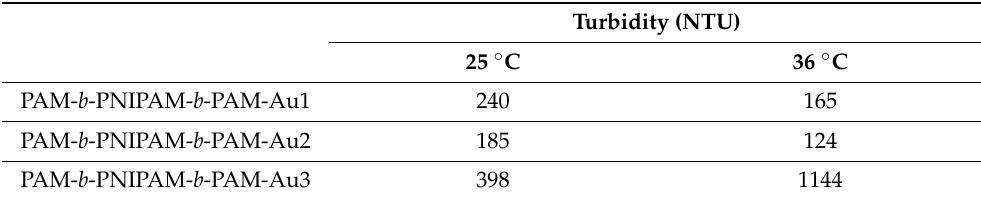
Figure 5. DLS number–size distribution of the nanocomposites in solution. By increasing the length of the size of the PAM block and decreasing the PNIPAM’s block size, a larger size distribution is observed. This might indicate the formation of aggregates between both components, the copolymer and the gold nanoparticles, due to the good affinity between PAM and AuNPs. Table 3. Turbidimetry values obtained at room temperature (25 ◦ C) and at a temperature above the LCST (36 ◦